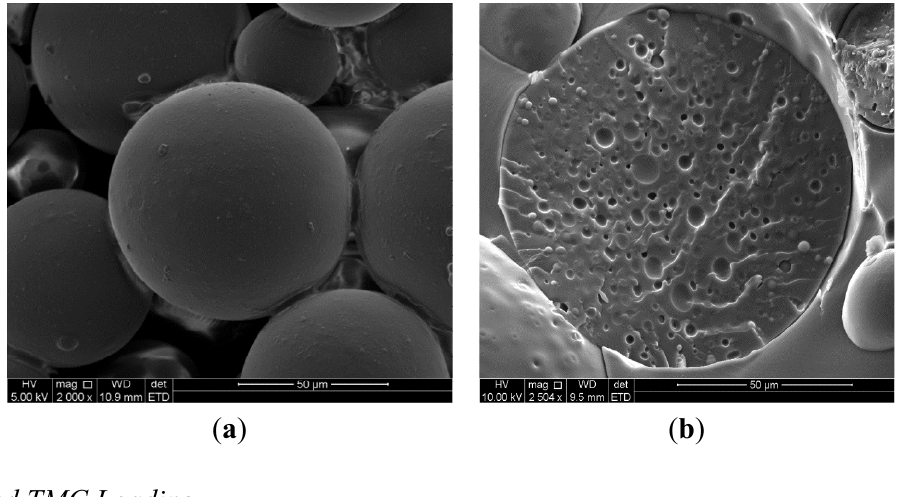
Figure 1. Scanning electron micrograph of a microsphere formulation consisting of Eudragit ® L100 (3.5% w/w), TMC (5% w/w) and insulin (2% w/w) showing ( a ) surface morphology (2000× magnification) and ( b ) internal structure (2500×